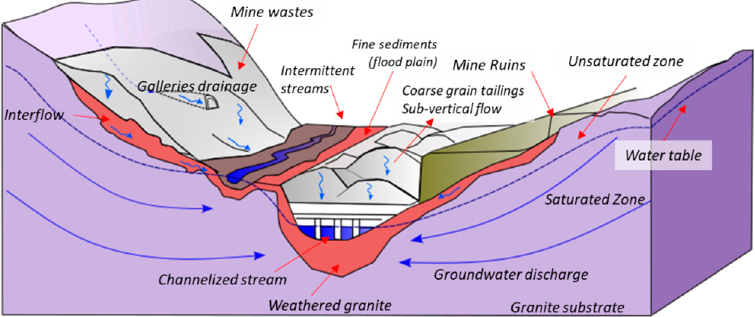
Figure 10. A hydrogeological conceptual model for the Regoufe mining area.